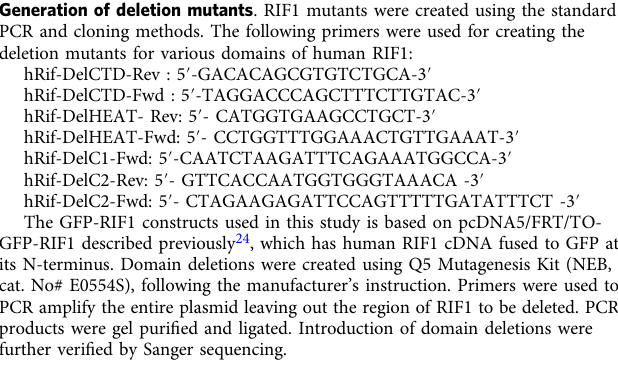
The GFP-RIF1 constructs used in this study is based on pcDNA5/FRT/TO- GFP-RIF1 described previously 24 , which has human RIF1 cDNA fused to GFP at its N-terminus. Domain deletions were created using Q5 Mutagenesis Kit (NEB, cat. No# E0554S), following the manufacturer ’ s instruction. Primers were used to PCR amplify the entire plasmid leaving out the region of RIF1 to be deleted. PCR products were gel puri fi ed and ligated. Introduction of domain deletions were further veri fi ed by Sanger sequencing.